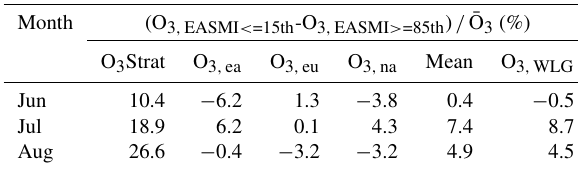
Table 5. The changes in stratospheric ozone input and in ozone con- centration associated with East Asian, European, and North Amer- ican transport (%) introduced by the East Asian summer monsoon. The average ozone values associated with the EACOt ≥ 67th, EU- COt ≥ 67th, and NACOt ≥ 67th are used to represent the ozone transported from East Asia (O 3 , ea ), Europe (O 3 , eu ) , and North America (O 3 , na ). The East Asian summer monsoon index (EASMI) is used to filter out those O 3 , ea , O 3 , eu , and O 3 , na values associated with the lower and upper 15th percentiles of EASMI. The relative change induced by the East Asian Monsoon is then calculated with the equation (O 3 , EASMI < = 15th-O 3 , EASMI > = 85th) / ¯O 3 .